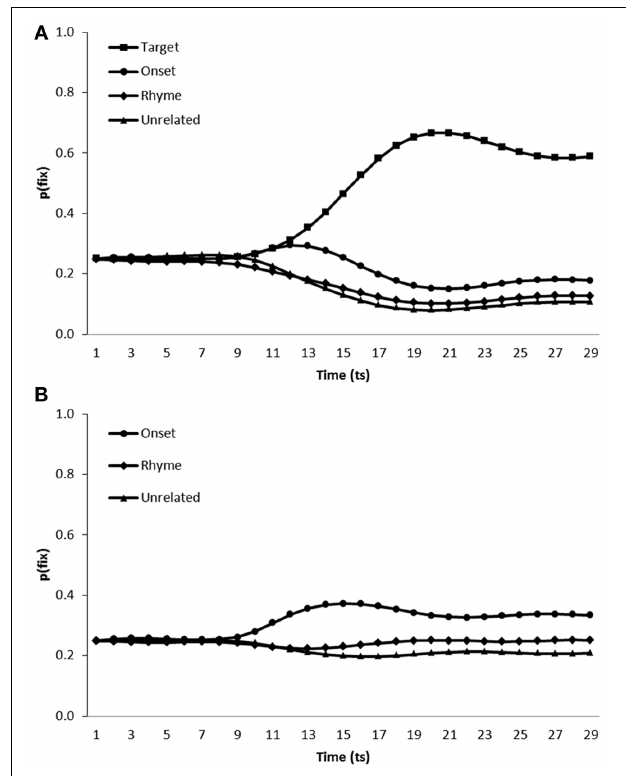
FIGURE 5 | Proportion of fixations [p(fix)] directed toward items within scenes containing (A) a target, an onset competitor, a rhyme competitor and an unrelated distractor, (B) an onset competitor, a rhyme competitor and two unrelated